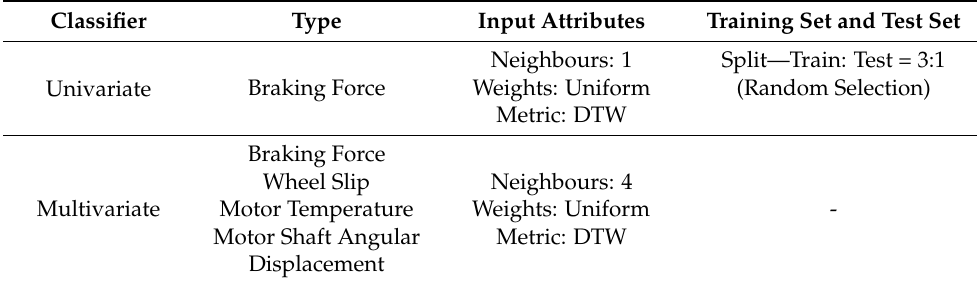
Table 6. k-NN Model